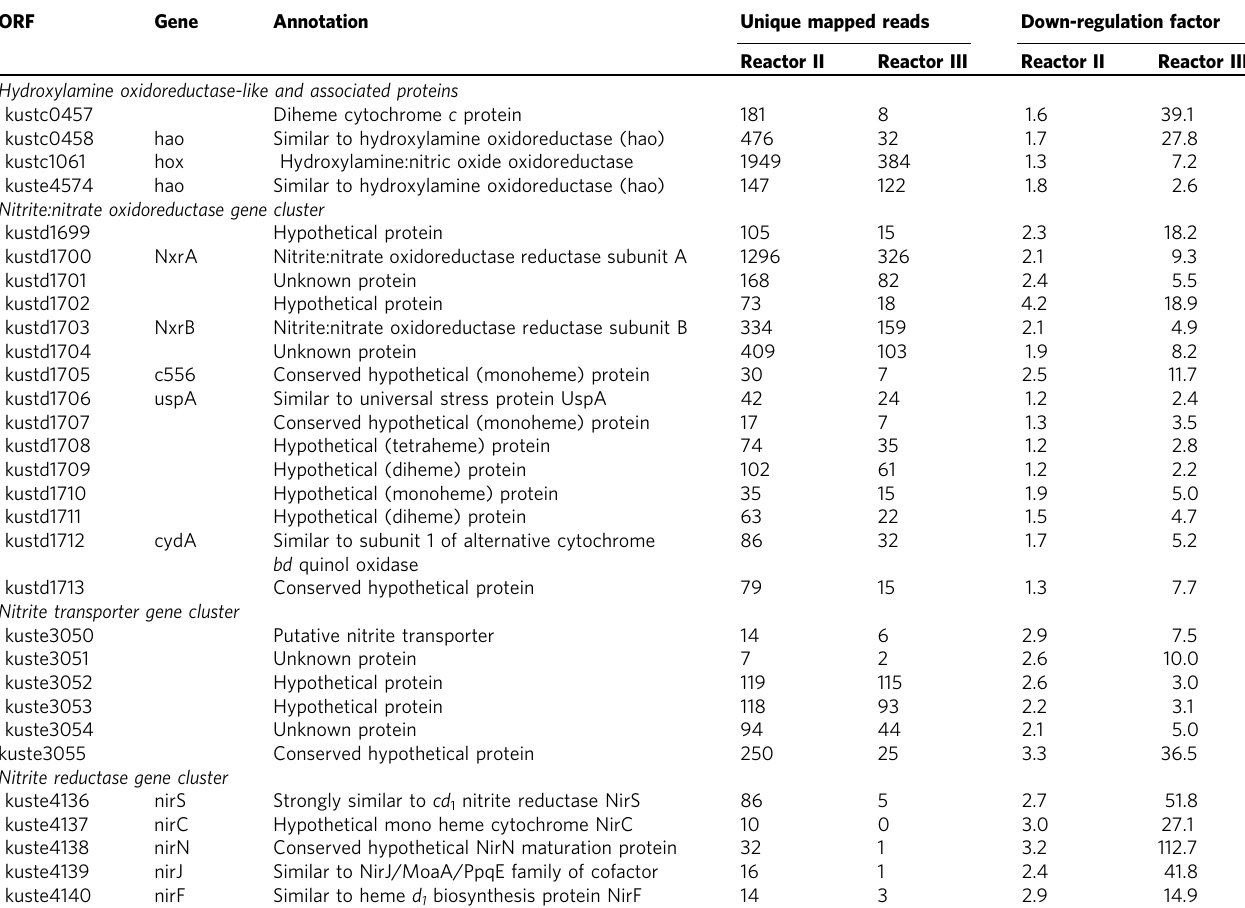
Table 1 Down-regulation of Kuenenia stuttgartiensis genes involved in nitrite and NO metabolisms ORF Gene Annotation Unique mapped reads Down-regulation